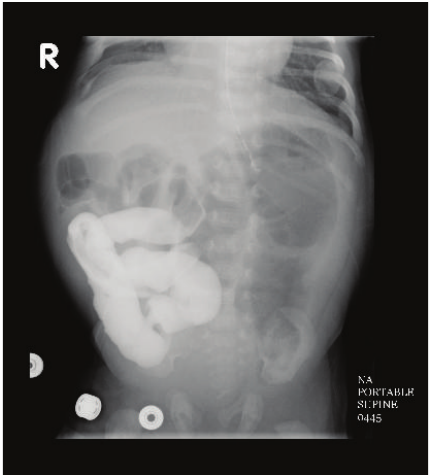
Figure 3: Upper gastrointestinal small bowel follow-through show- ing no progression of contrast beyond the right side of the abdomen after 4 days suggestive of obstruction. Previous enteroenterostomy appears